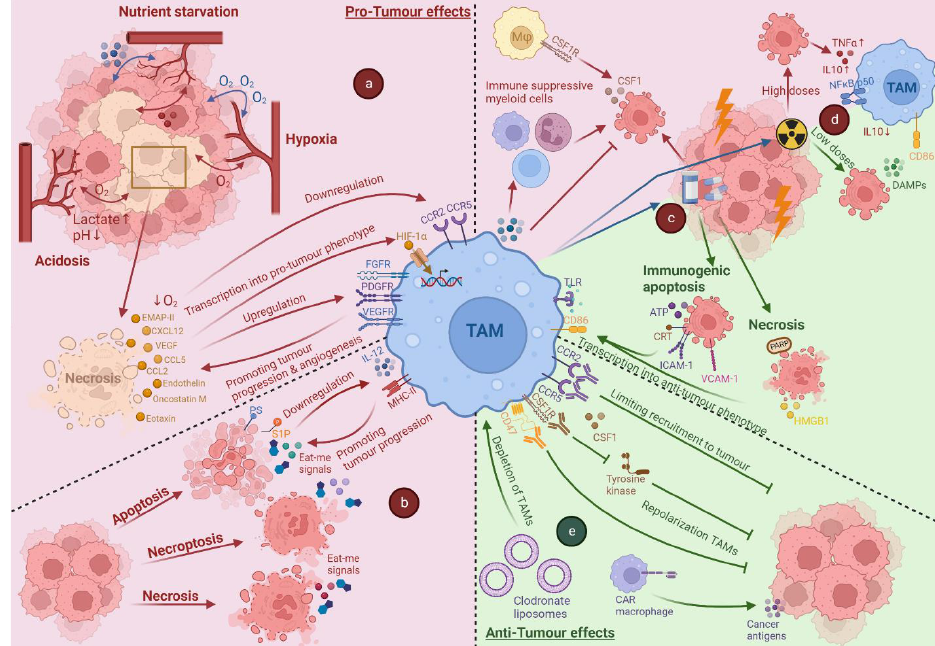
Figure 2. Overview of the impact of cell death due to tumour-associated stress or induced by anti-cancer therapy and the effect of immunotherapy on TAMs. In hypoxic and necrotic areas, recruitment of TAMs occurs through expression of chemoattractant molecules, such as C-C motif chemokine ligands 2 and 5 (CCL2 and CCL5), C-X-C motif chemokine ligand 12 (CXCL12), endothelin, vascular endothelial growth factor (VEGF), endothelial monocyte-activating polypeptide-II (EMAP- II), oncostatin M and eotaxin. Once in hypoxic areas, the conditions will downregulate C-C motif chemokine receptors 2 and 5 (CCR2 and CCR5) causing retention and entrapment of TAMs in the tumour. This will induce transcription in TAMs by upregulating hypoxia-inducible factors-1 and -2 (HIF-1, HIF-2). Simultaneously, hypoxia can promote surface expression of VEGF receptor, platelet-derived growth factor receptor (PDGFR) and fibroblast growth factor receptor (FGFR). Besides hypoxia, acidosis and nutrient starvation can both affect macrophage metabolism leading to pro-tumour effects ( a ). Cancer cells undergoing apoptosis will expose eat-me signals, such as phosphatidylserine (PS) and sphingosine-1-phosphate (S1P), which can reduce production of interleukin 12 (IL 12) and downregulate main histocompatibility complex-II (MHC-II) presented by TAMs. Both accidental and programmed necrosis (i.e.,) necroptosis, secrete eat-me signals that will cause a pro-tumour effect ( b ). Chemotherapy can induce cell death, resulting in high expression of colony-stimulating factor 1 (CSF1) on the cancer cells. This will attract CSF1-receptor (CSF1R) positive macrophages together with TAMs, which secrete stimulatory factors to recruit other immune- suppressive myeloid cells. However, certain chemotherapies can induce immunogenic apoptosis leading to exposure/secretion of calreticulin (CRT), intercellular adhesion molecule (ICAM)-1 and vascular cell adhesion molecule (VCAM)-1 and adenosine triphosphate (ATP). When deficiency in the apoptosis pathway, necrosis is stimulated, and the interaction of released high mobility group box 1 (HMGB1) with Toll-like receptors (TLRs) triggers pro-inflammation ( c ). Depending on the doses, radiotherapy can reprogram TAMs to a phenotype sustained by nuclear factor kappa-light-chain- enhancer of activated B cells B (NF κ B) p50 activation that leads to IL10 and tumour necrosis factor α (TNF α ) secretion. Low doses can induce secretion of damage-associated molecular patterns (DAMPs) and upregulation of cluster of differentiation 86 (CD86) ( d ). Limiting of TAMs at tumour sites can be performed by blocking C-C chemokine receptors 2 and 5 (CCR2 and CCR5). Repolarisation of the TAMs is performed by blocking the CSF1-CSF1R interaction through antibodies, by inhibiting tyrosine kinases or by blocking CD47. Depleting TAMs can be performed by using clodronate liposomes to induce apoptosis. Lastly, CAR macrophages can induce phagocytosis of cancer antigens ( e